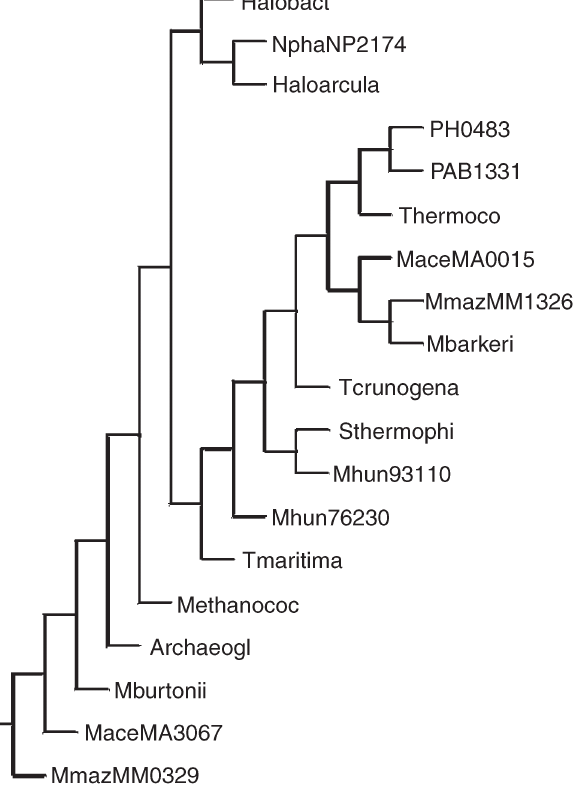
Figure A4. Phylogenetic analysis by neighbor-joining of putative two-component open reading frames (ORFs) from response regulator IV groups arr18 and arr19 . Group arr18 = MaceMA0015, MbarA_0985 and MmazMM1326; and group arr19 = PAB1331, PH0483, Tkod_610170410, HaloVNG0973G, HmarrnAC2204, MaceMA3067, MmazMM0329, Mbur_401647530, AfulAF1041, MmarMMP0926, NphaNP2174A and Mhun_401793110. The bacte- rial ORFs are Sthermophilum and Tmaritima, Tcrunogena. Abbre- viations: Thermoco = T. kodakaraensis ; Sthermophilum = S. thermophilum _3768360; Tmaritima = T.maritima MSB8_21060; and Tcrunogena = T. crunogena Tcr0758.